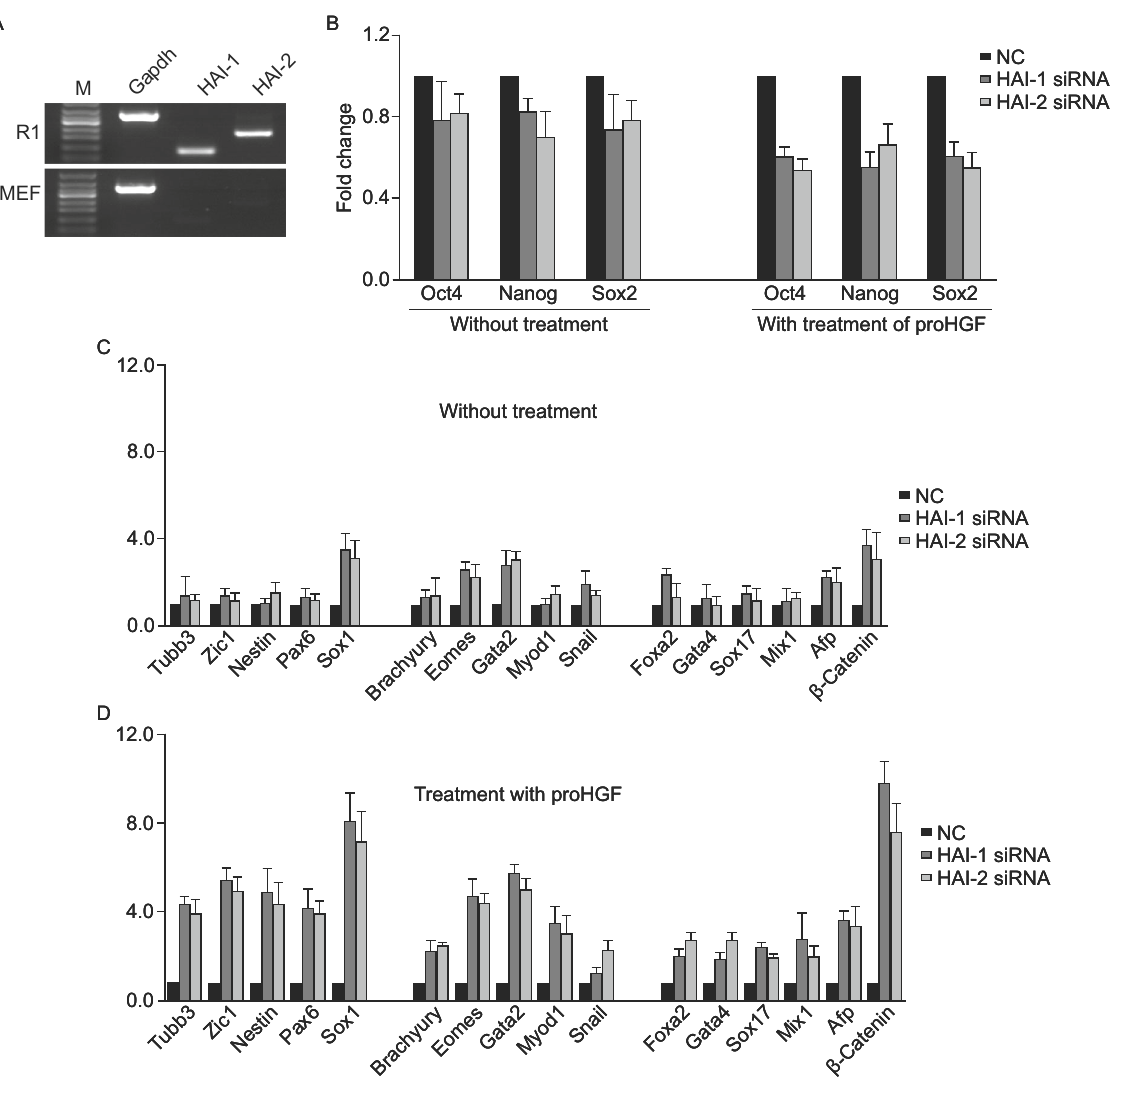
Figure 2. Differential expression of HAIs in R1 and MEF, and their activity associated with proHGF treatment . (A) The expression of HAIs in mESCs and MEFs; (B) The expression of pluripotent genes Oct4 , Nanog , and Sox2 in HAIs-KD mESCs in the presence and/or absence of proHGF; (C and D) The expression of differentiation genes after KD of HAI-1 and HAI-2 in the absence (C) or presence of proHGF